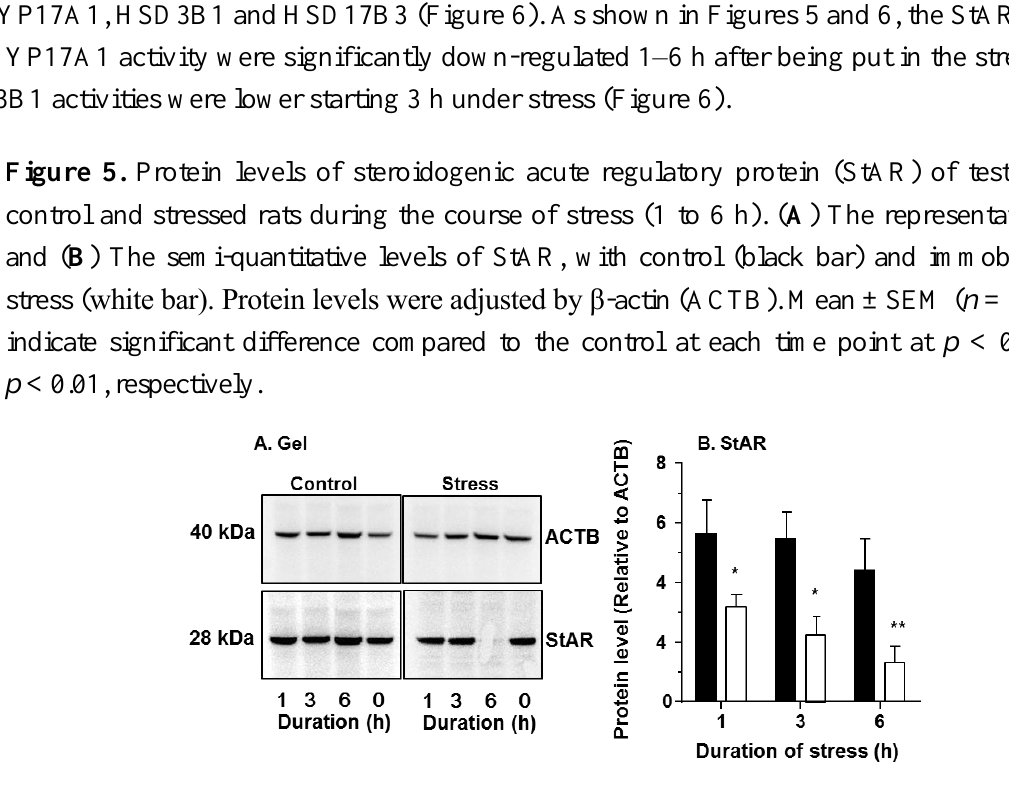
Figure 6. Steroidogenic enzyme activities in the testes from control and stressed rats during the course of immobilization stress. ( A ) 17α-hydroxylase/17,20-lase (CYP17A1) to catalyze progesterone (P4) to androstenedione (D4); ( B ) 3β-hydroxysteroid dehydrogenase 1 (HSD3B1) to catalyze pregnenolone to P4; and ( C ) 17β-hydroxysteroid dehydrogenase 3 (HSD17B3) to catalyze D4 to testosterone (T). Mean ± SEM ( n = 6). LogV = log velocity (µg/mg protein.min). * , *** indicate significant difference compared to control (CON) at each time point at p < 0.05 or p < 0.001,